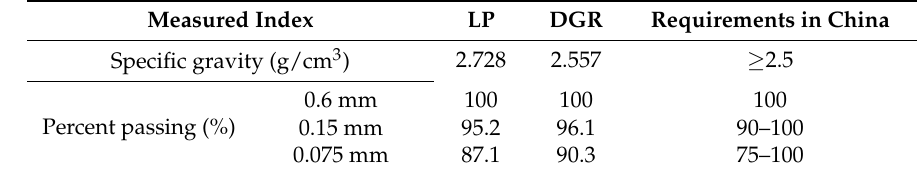
Table 3. Basic technical properties of fillers.